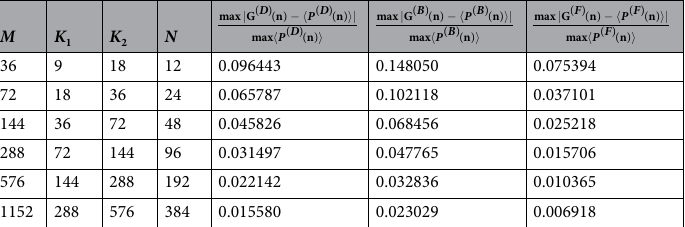
Table 1. The numerically computed  − P the three bin partition with q 1 = q 3 = 1/4 and q 2 = 1/2. The maximum is taken over all distributions n = ( n 1 , n 2 , n 3 ) of N particles over the output